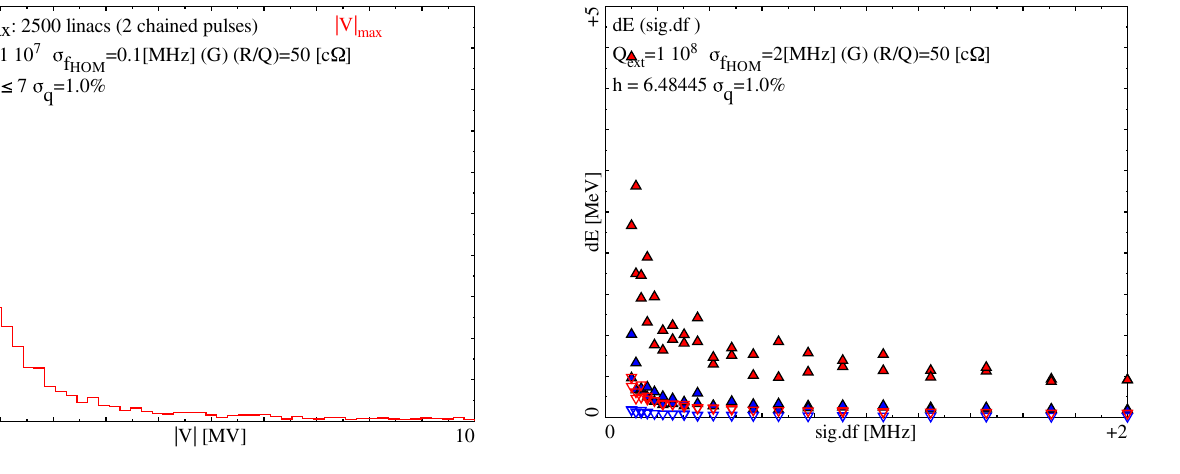
FIG. 25. (Color) Histogram of highest cavity voltages [0– 10 MV, 50 bins] for Q ext ¼ 10 7 (0–400 000) over 2500 different HOM setups; conditions as in Fig. 11.